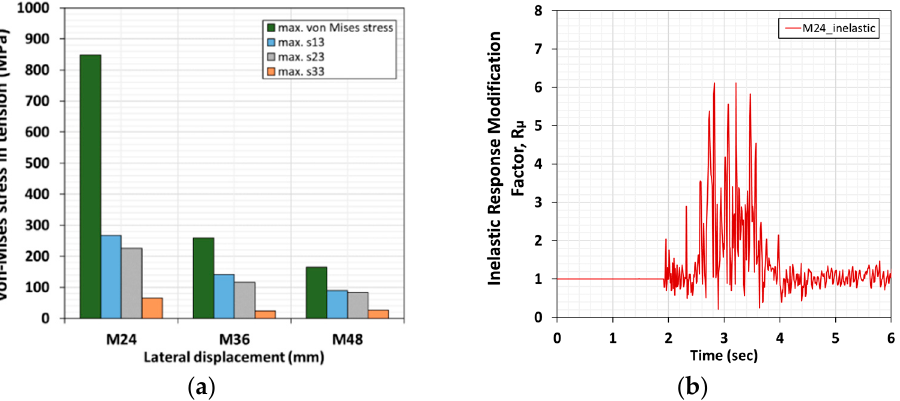
Figure 25. ( a ) von-Mises stress variations with anchor size. ( b ) Response modification factors measured during an earthquake.